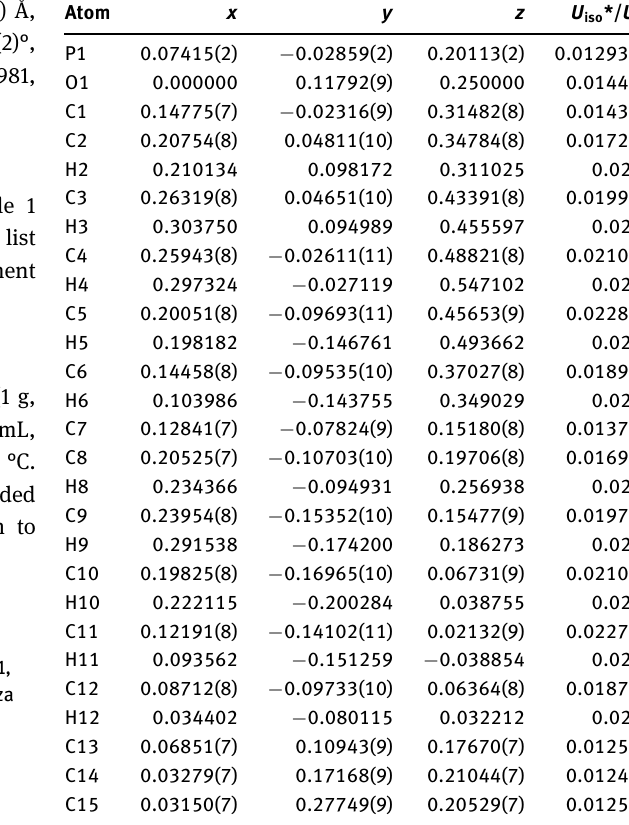
Table 2: Fractional atomic coordinates and isotropic or